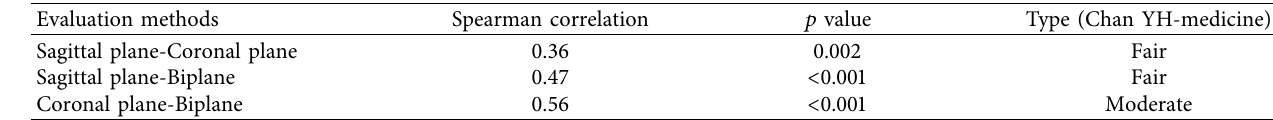
Table 6: The Spearman correlation between evaluation methods.